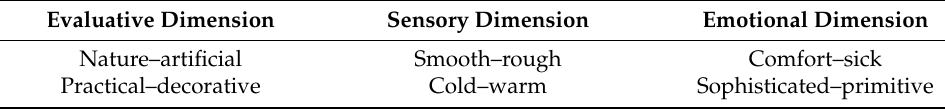
Table 2. Results of typical semantic bipolar adjectives in three dimensions.